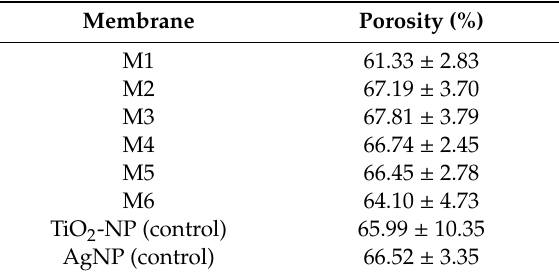
Table 5. Porosity of the